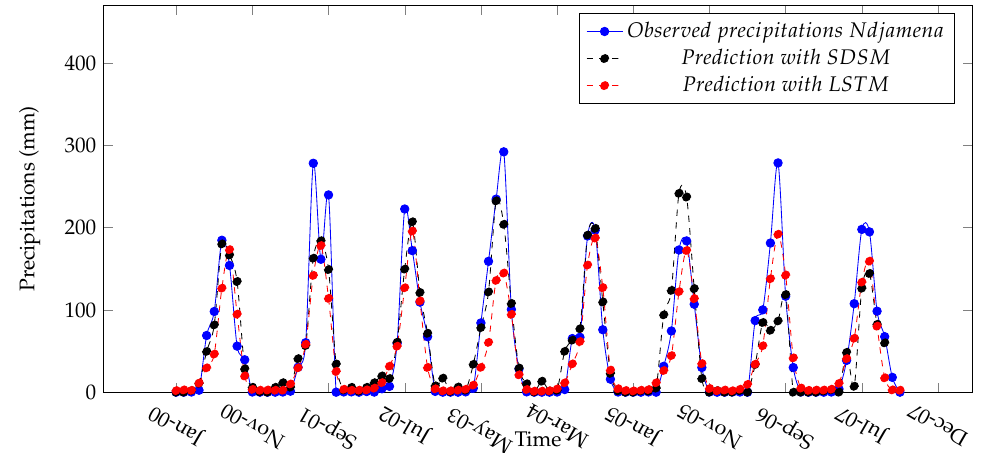
Figure 12. Observed and predicted precipitation in Ndjamena.